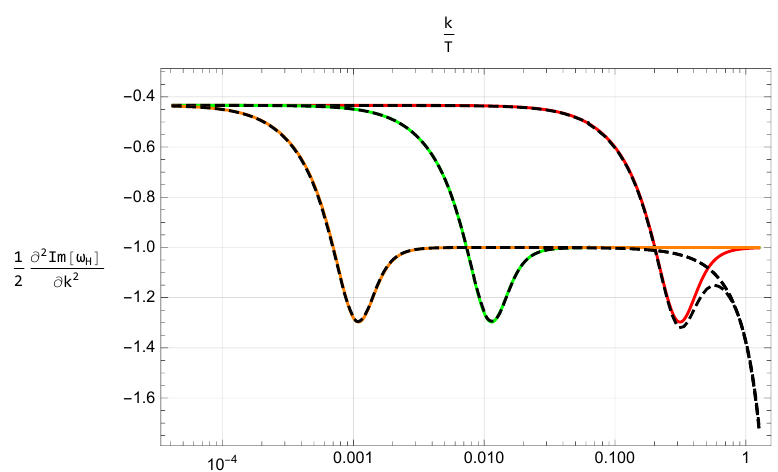
∂ 2 Im ω H Figure 1 . Plot of 1 for the Higgs mode as a function of k for three values of the chemical 2 ∂k 2 potential µ c = 0 . 99999999 , µ c = 0 . 999998932 , µ c = 0 . 9991919498 . The dashed lines corre- µ orange µ green µ red spond to the numerical results and the solid lines to the analytic